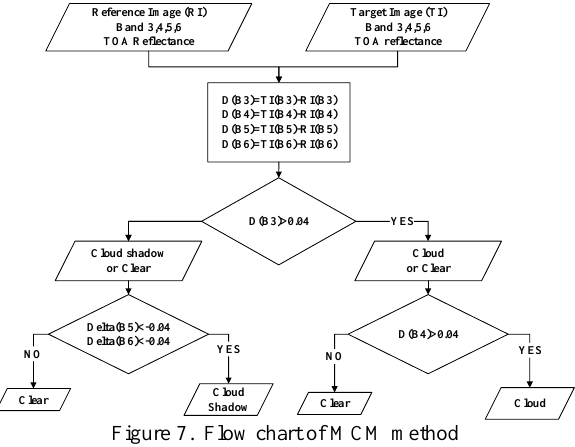
Figure 7. Flow chart of MCM method